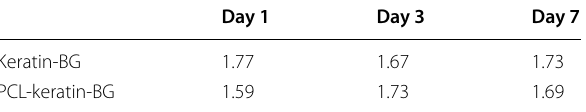
Table 1 The radio of calcium to phosphorus (Ca/P) of HA after mineralization in keratin-BG and PCL-keratin-BG